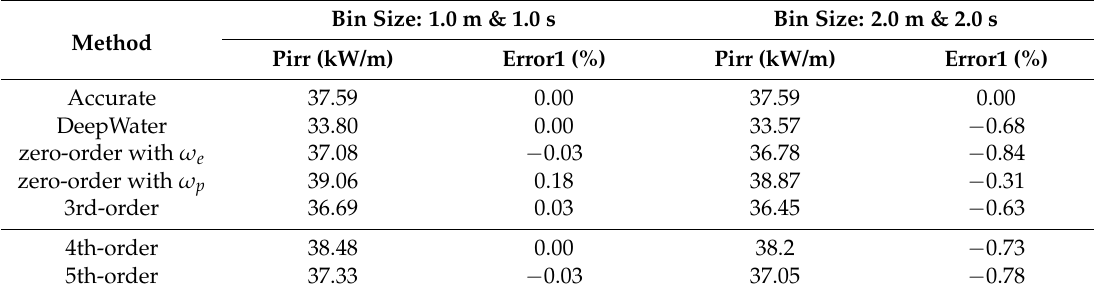
Table 2. Wave power assessment for AMETS (water depth: 50